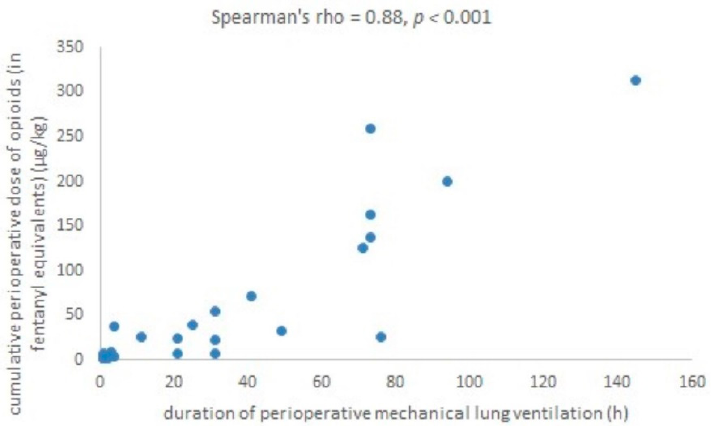
Figure 3. Correlation between duration of perioperative mechanical ventilation and cumulative perioperative dose of opioids.